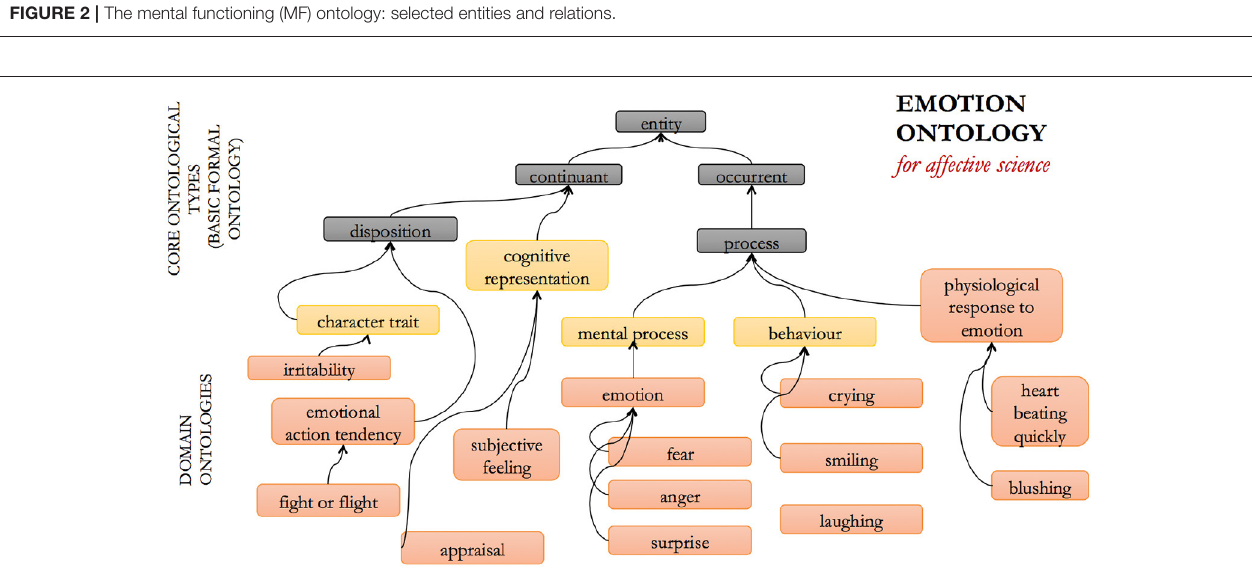
FIGURE 2 | The mental functioning (MF) ontology: selected entities and relations.